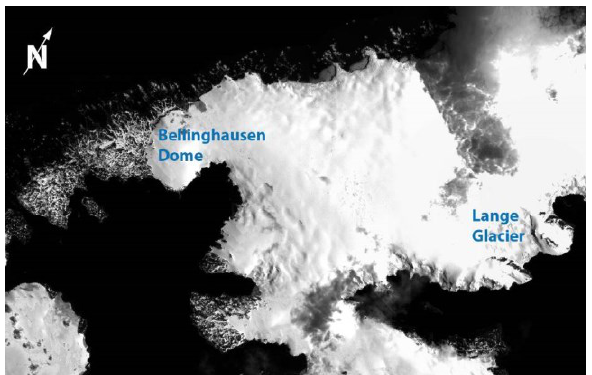
Figure 1: Western part of King George Island and field site for ground measurements (source: LIMA Mosaic -